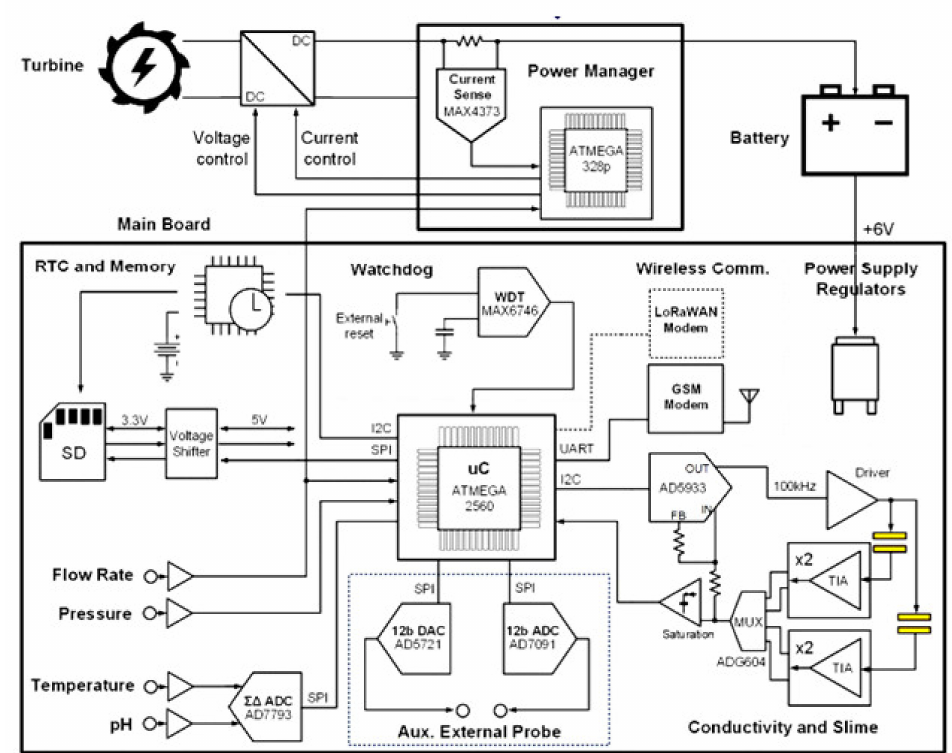
Figure 6. Main circuitry of the system proposed in